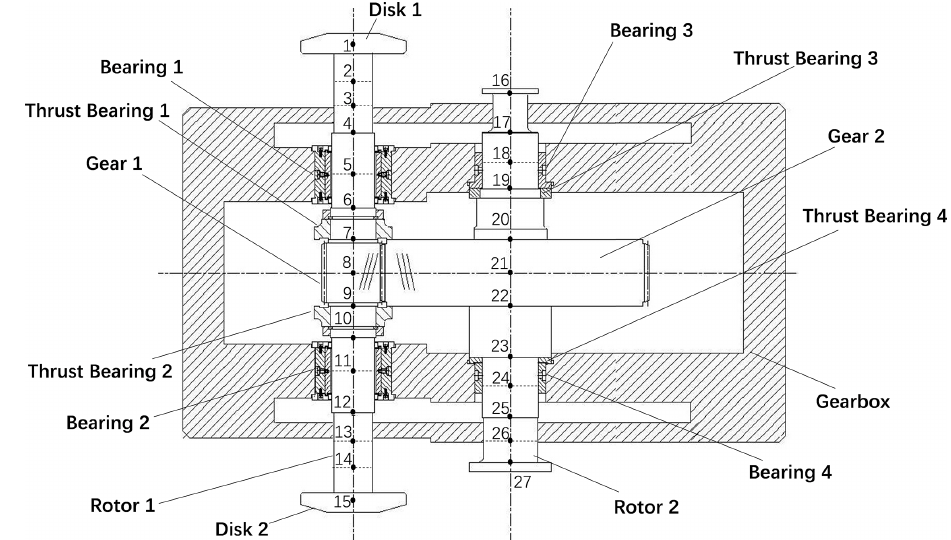
Figure 1. Typical structure of the gear-rotor system.